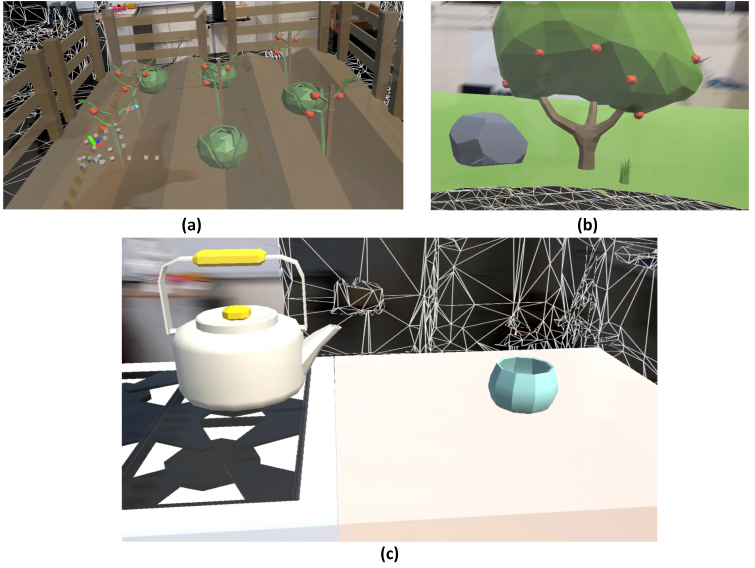
Figure 3. Game levels shown in the Microsoft HoloLens 2 AR environment with its spatial awareness feature (i.e., recognizing and including the room details) ( a ) Picking cabbages in the garden. ( b ) Picking apples from a tree. ( c ) Pouring a cup of